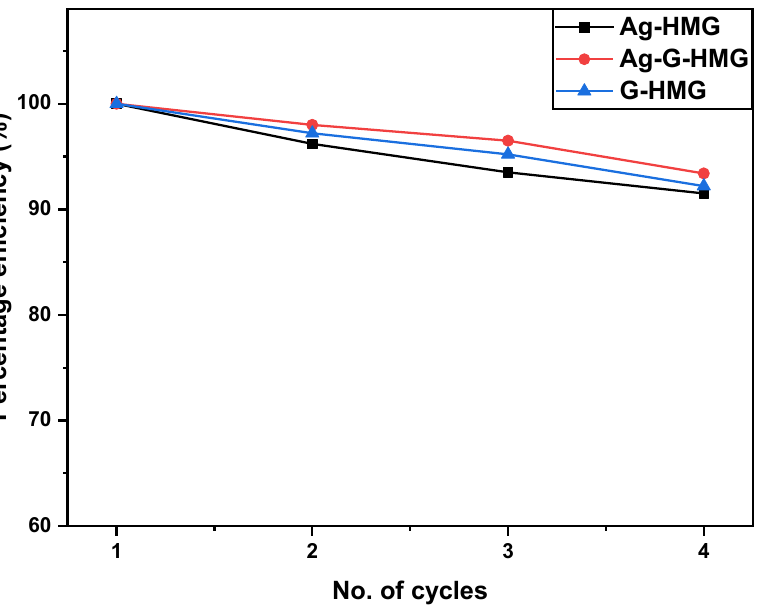
Figure 6. Percentage of efficiency of catalysts as a function of the number of cycles.